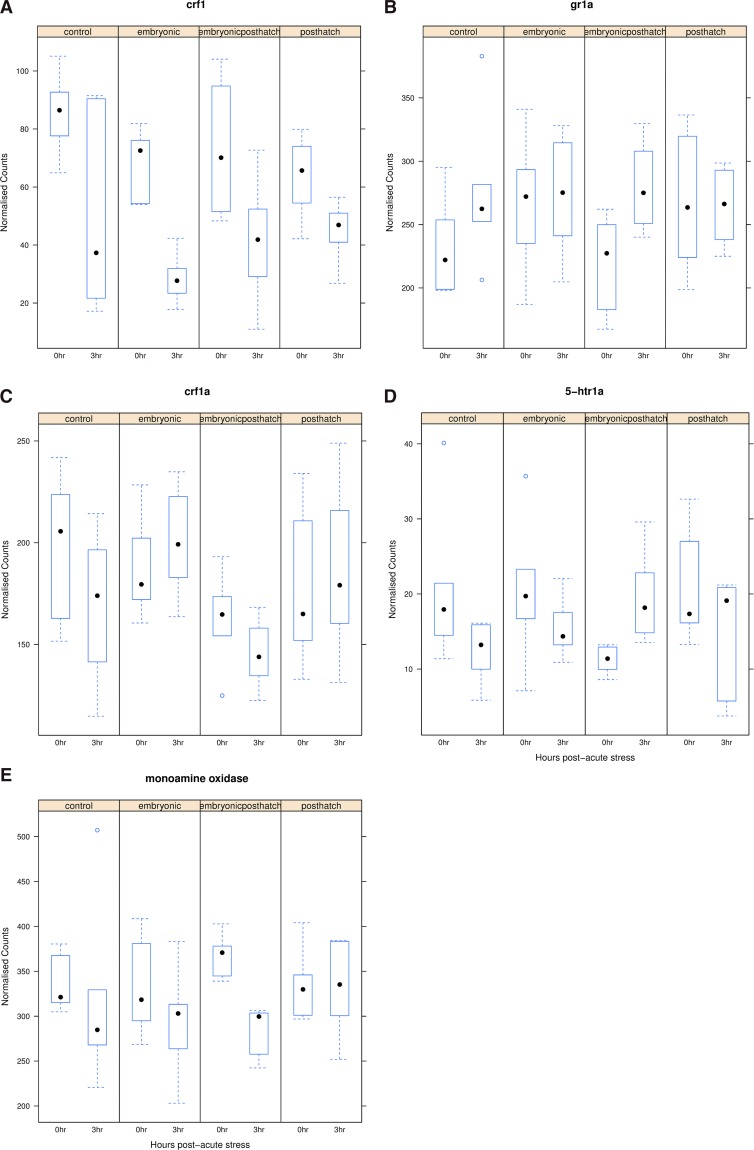
Box plot of changes in the expression of corticotropin releasing factor 1 (crf1, A), glucocorticoid receptor 1a (gr1a, B), corticotropin releasing factor receptor 1 (crf1a, C), 5-hydroxytryptamine receptor 1A (5-htr1a, D) and monoamine oxidase (E) for control (CO), embryonic (E), post-hatch (PH) and embryonic post-hatch (EPH) treated fish at 0 and 3 hr post-acute stress.